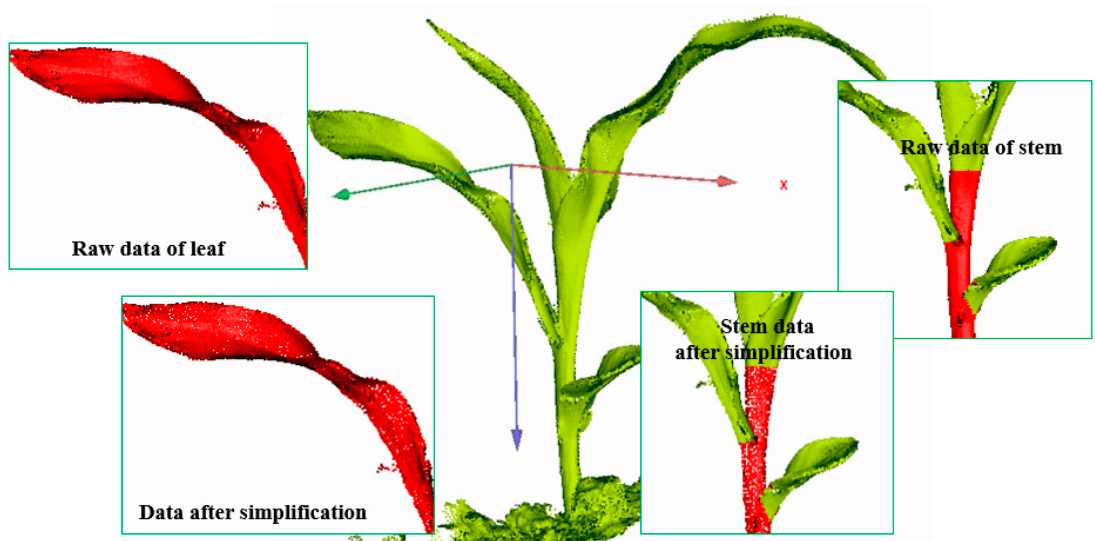
Figure 9. Example of the point cloud simplification effect in maize plants.